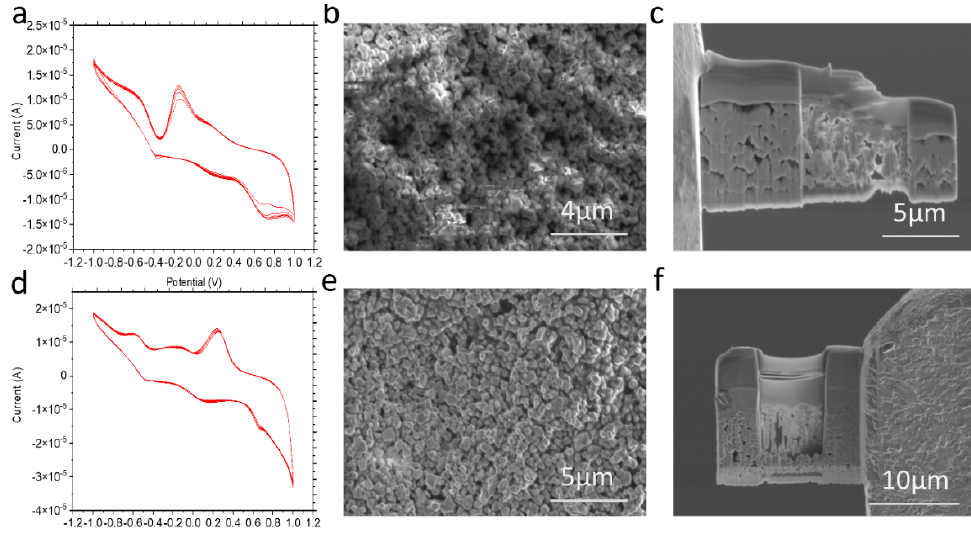
Figure 2. ( a ) CV results of CeO 2 -applied electrochemical cell using 5% Nafion, 1000 rpm spin rate and 80 mV/s scan rate, ( b ) SEM image of the CeO 2 WE surface after electrochemical corrosion with a magnification of 14,000 X, ( c ) SEM-FIB image of the suspended lamella from the corroded CeO 2 WE surface with a magnification of 12,000 X, ( d ) CV results of the Nafion only control using 5 wt% Nafion 500 rpm spin rate and 80 mV/s scan rate, ( e ) SEM image of the pristine CeO 2 WE surface with a magnification of 12,000, and ( f ) SEM-FIB image of the suspended lamella from the pristine CeO 2 WE surface with a magnification of 6500.